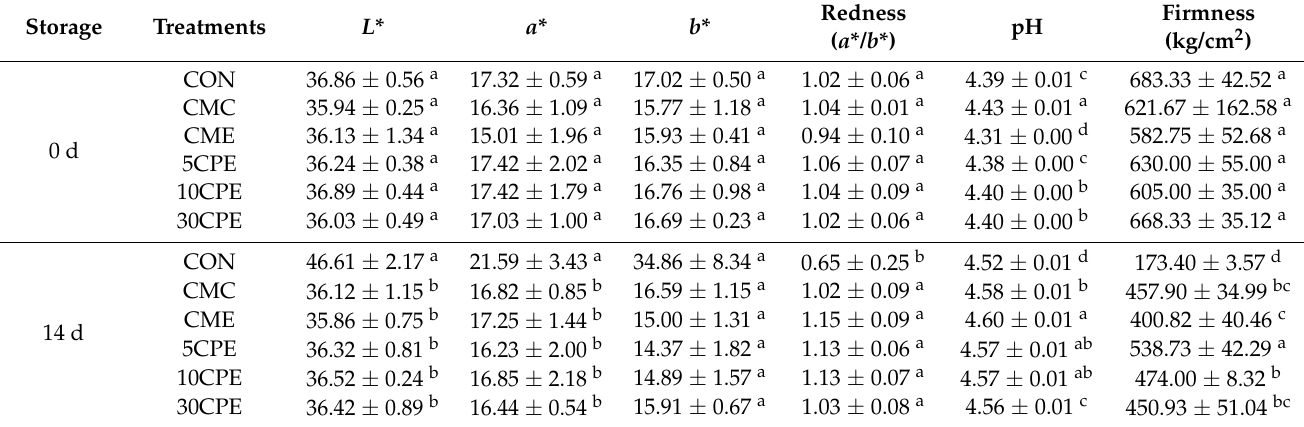
Table 6. Color properties, pH, and firmness of uncoated and OLP/CMC-coated cherry